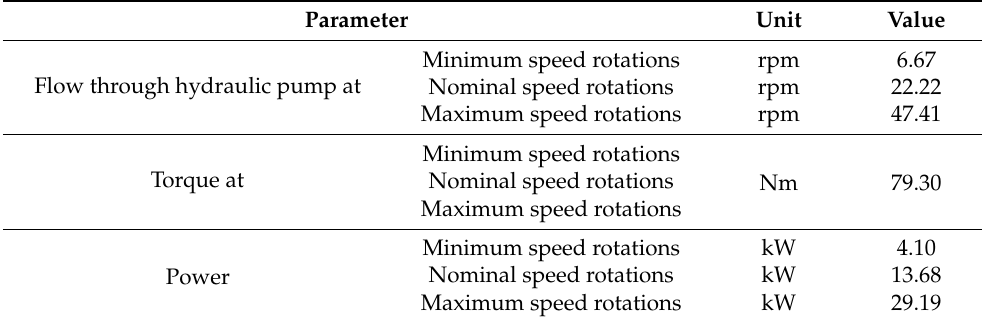
Table 6. Calculated values of the input hydraulic pump for the design of the electric motor.